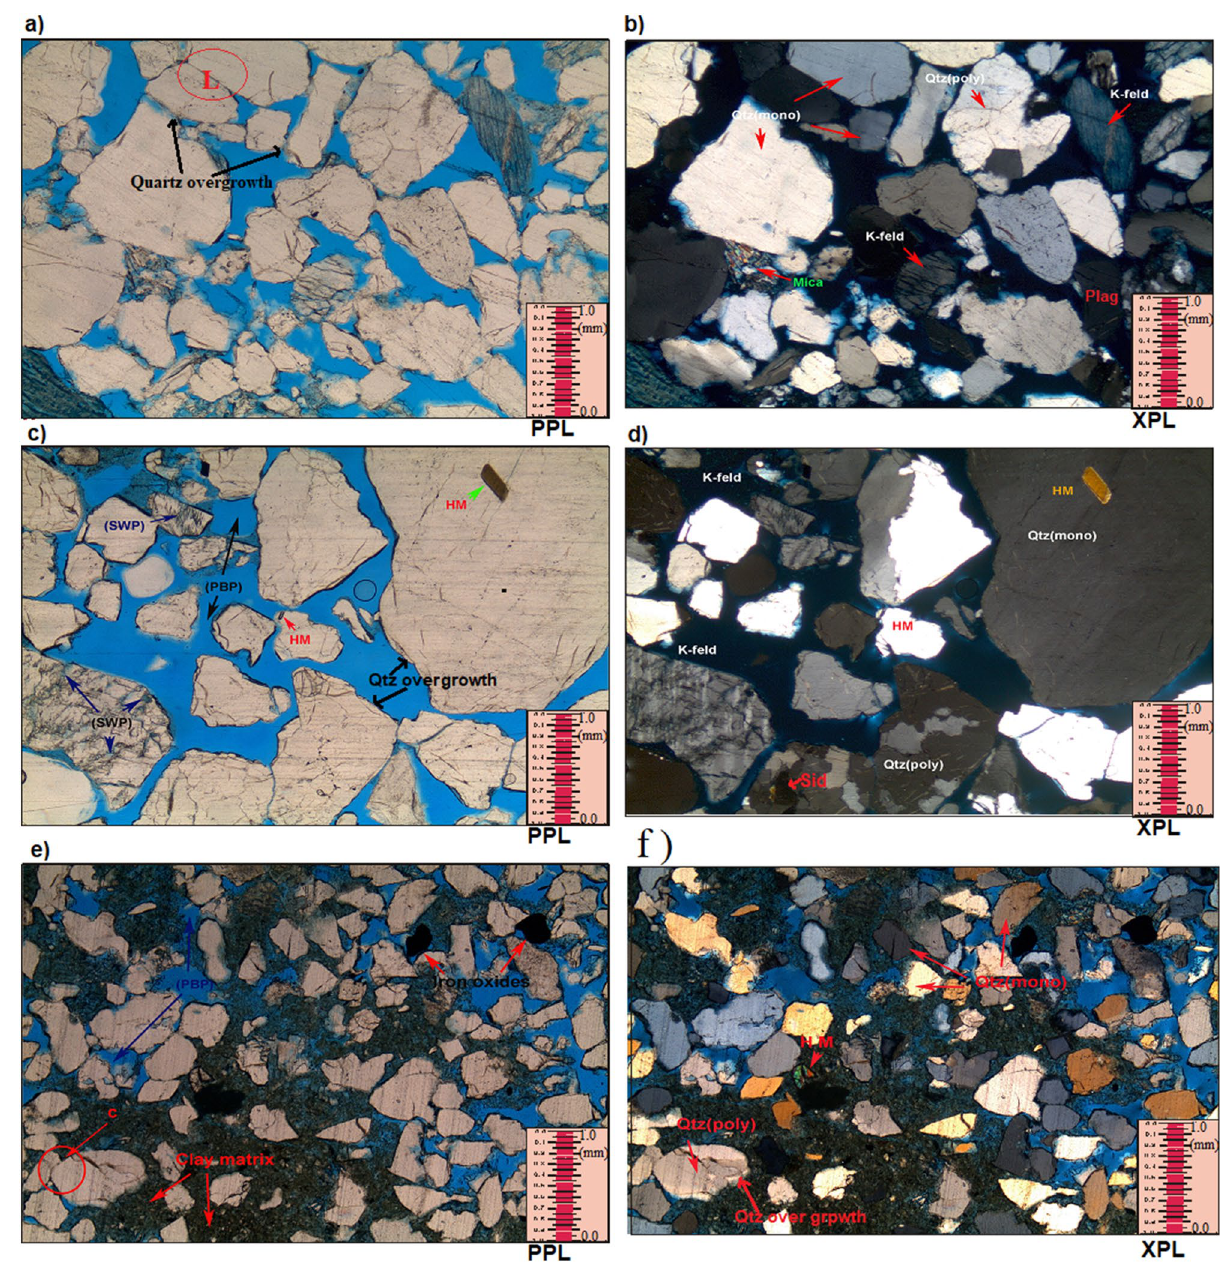
Figure 7. (a - f ); Massive sandstone (Sm) distinguished by medium to coarse-grained sandstones (average mU-cL) with the following attributes, moderate-well sorted; sub-rounded to sub -angular; patchy cemented also moderately compacted with point; concavo-convex with few amount of long grain contacts. Common polycrystalline quartz plus monocrystalline quartz, having considerable amount of potassic feldspar (mainly orthoclase feldspar showing partial dissolution), some quantities of plagioclase, minor amount of mica as well as heavy minerals (HM), occurring as free grains ( a - f ); Few amounts of iron oxides occurring as pore filling, spots of siderite cement as well as lesser quartz overgrowths (euhedral crystal termination around detrital quartz grains). ( c ); Very good pore interconnectivity of primary interparticle pores (PBP, impregnated with blue dyed resin), secondary inter-particle porosity (SWP) and secondary intra-particle porosity (SBP), usually via the partial dissolution of K-feldspar. ( e ); Some patches of pore filling with detrital